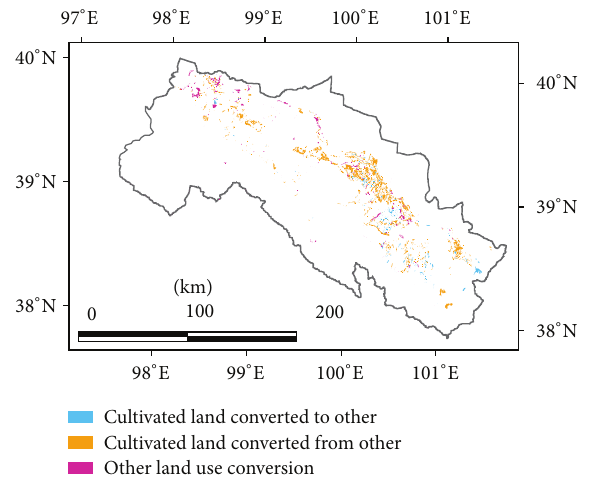
Figure 5: Spatial land use changes during 1988–2008.